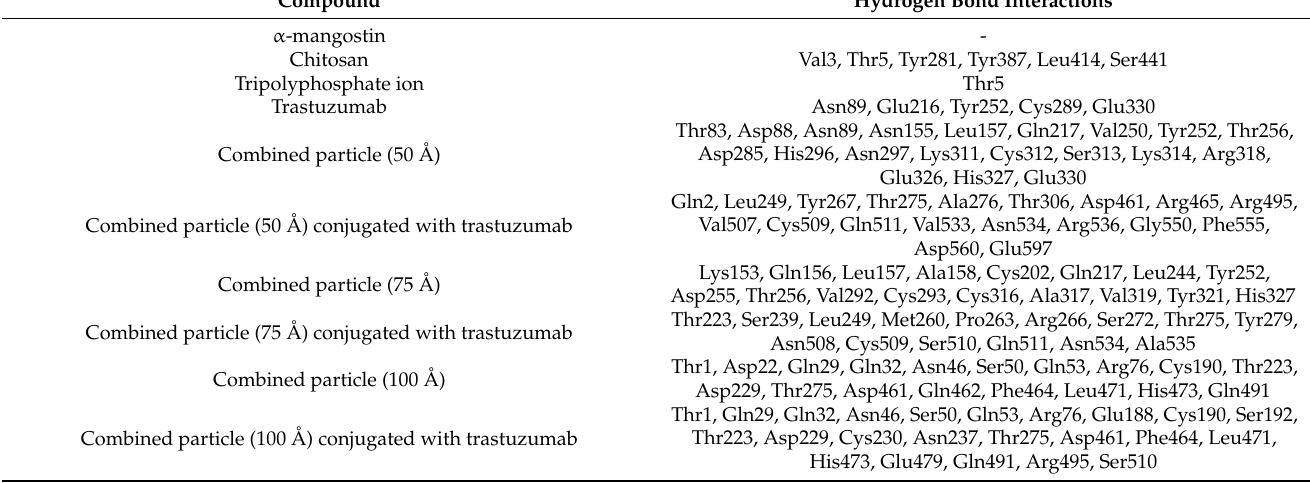
Table 6. Molecular docking simulation results of the preparation and its standards against